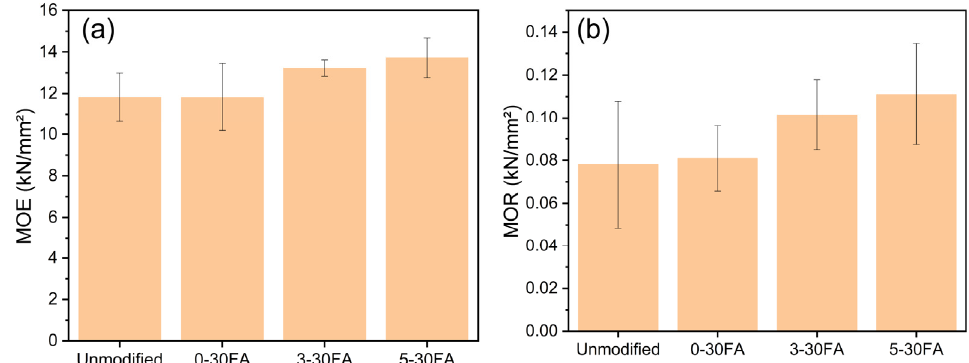
Figure 11. Three-point bending test to determine the ( a ) MOE and ( b ) MOR values of the unmodified wood specimen and of the 0-30FA, 3-30FA, and 5-30FA modified specimens.